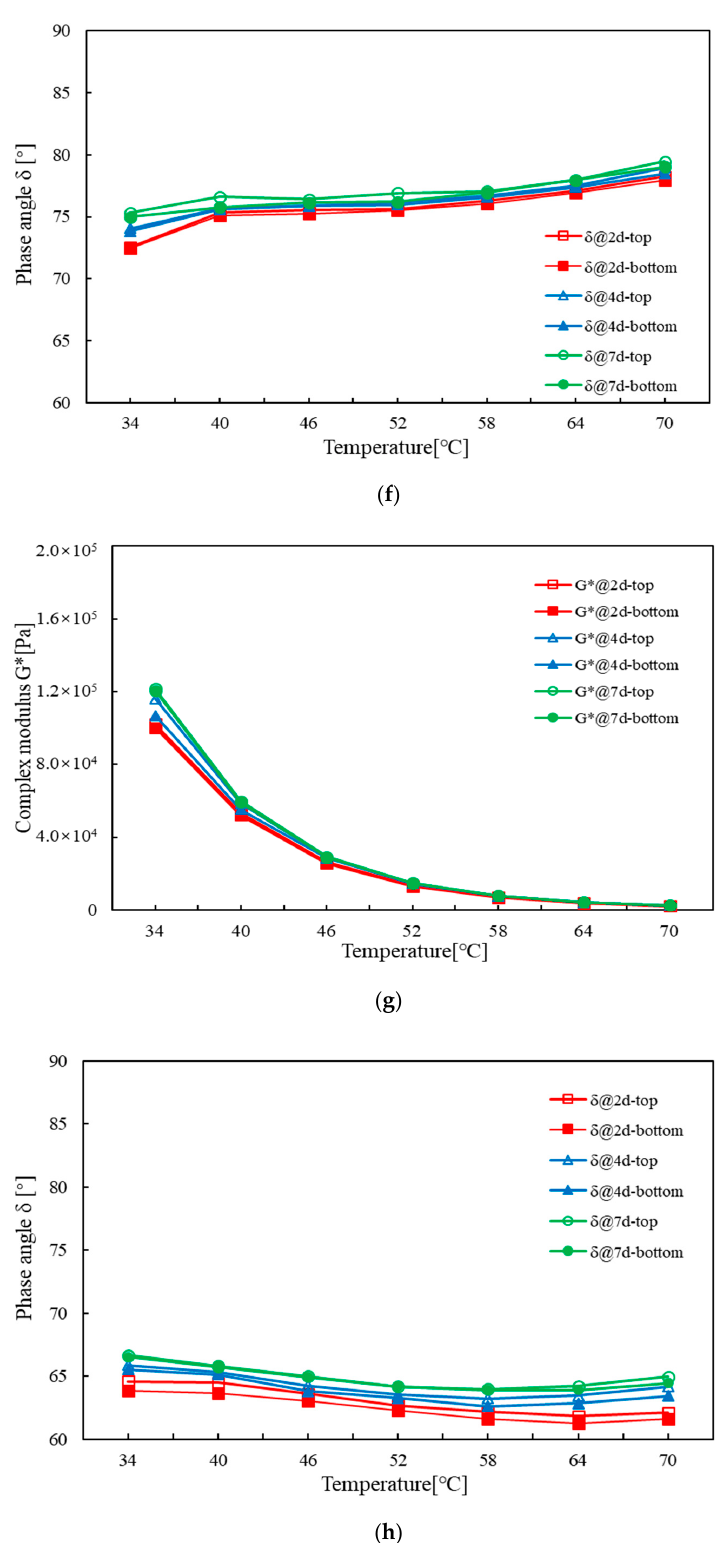
Figure 2. Rheological properties of various bitumen binders at different storage times: ( a ) complex modulus of Jingbo SG70 bitumen; ( b ) phase angle of Jingbo SG70 bitumen; ( c ) complex modulus of Jurong SG90 bitumen; ( d ) phase angle of Jurong SG90 bitumen; ( e ) complex modulus of Liaohe SG90 bitumen; ( f ) phase angle of Liaohe SG90 bitumen; ( g ) complex modulus of Jingbo PMB bitumen; ( h ) phase angle of Jingbo PMB